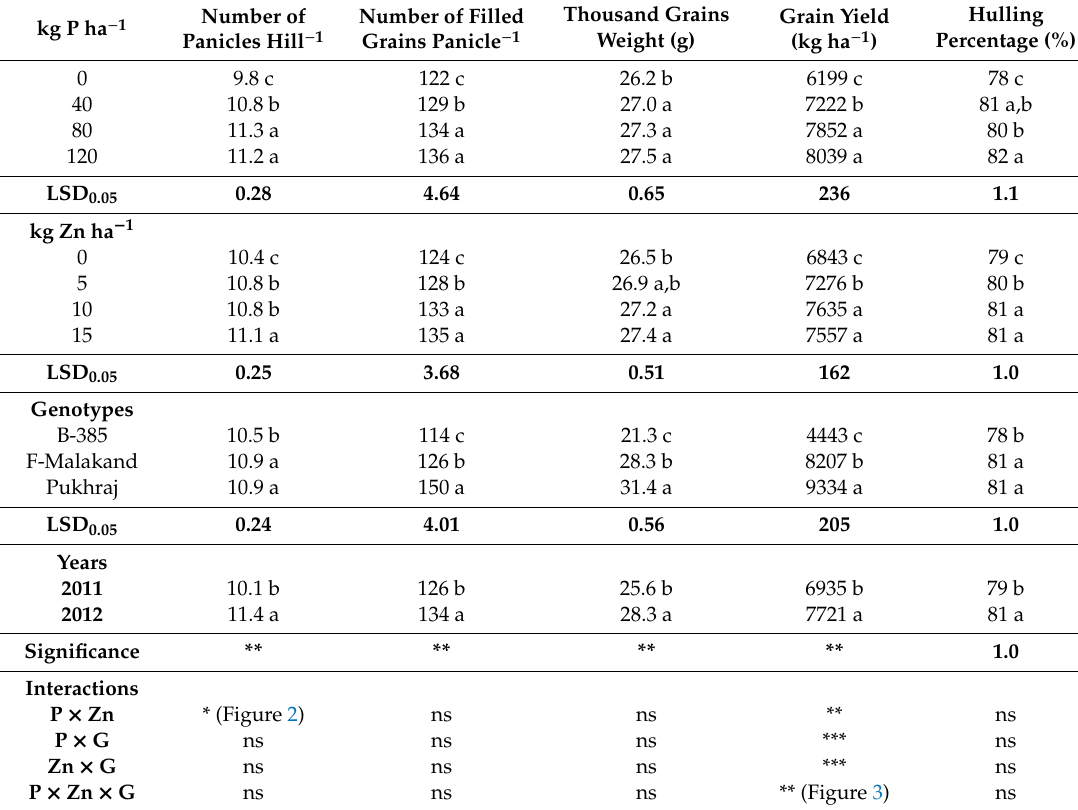
Table 1. Number of panicles hill − 1 , number of filled grains panicle − 1 , thousand grains weight (g), and grain yield (kg ha − 1 ) of rice genotypes, as a ff ected by phosphorus and zinc application.